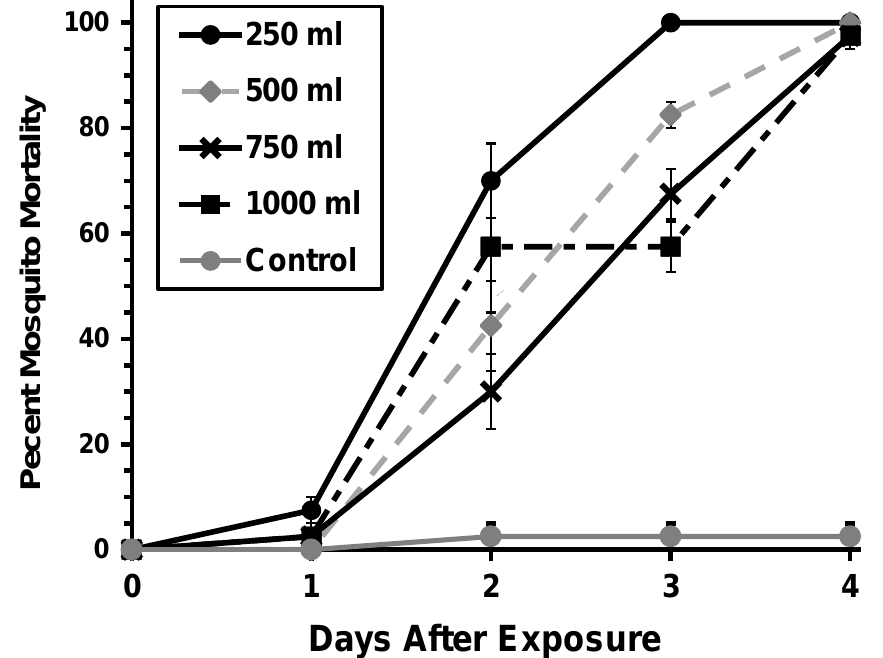
Figure 1. Effects of mosquitocidal chips containing 0.01% Pyriproxyfen on percent mortality of Ae. aegypti in varying water volumes. No mortality in untreated controls (not shown). Error bars represent ± standard error of the mean (SEM).